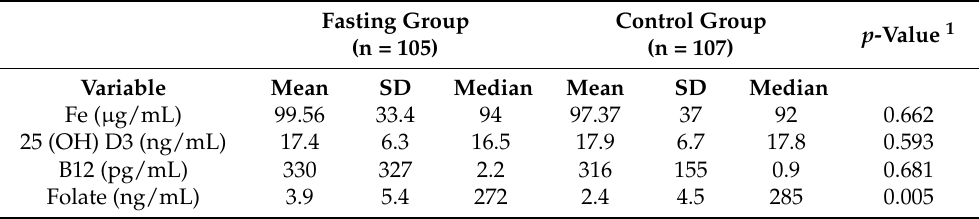
Table 2. Data on vitamins and ferrum